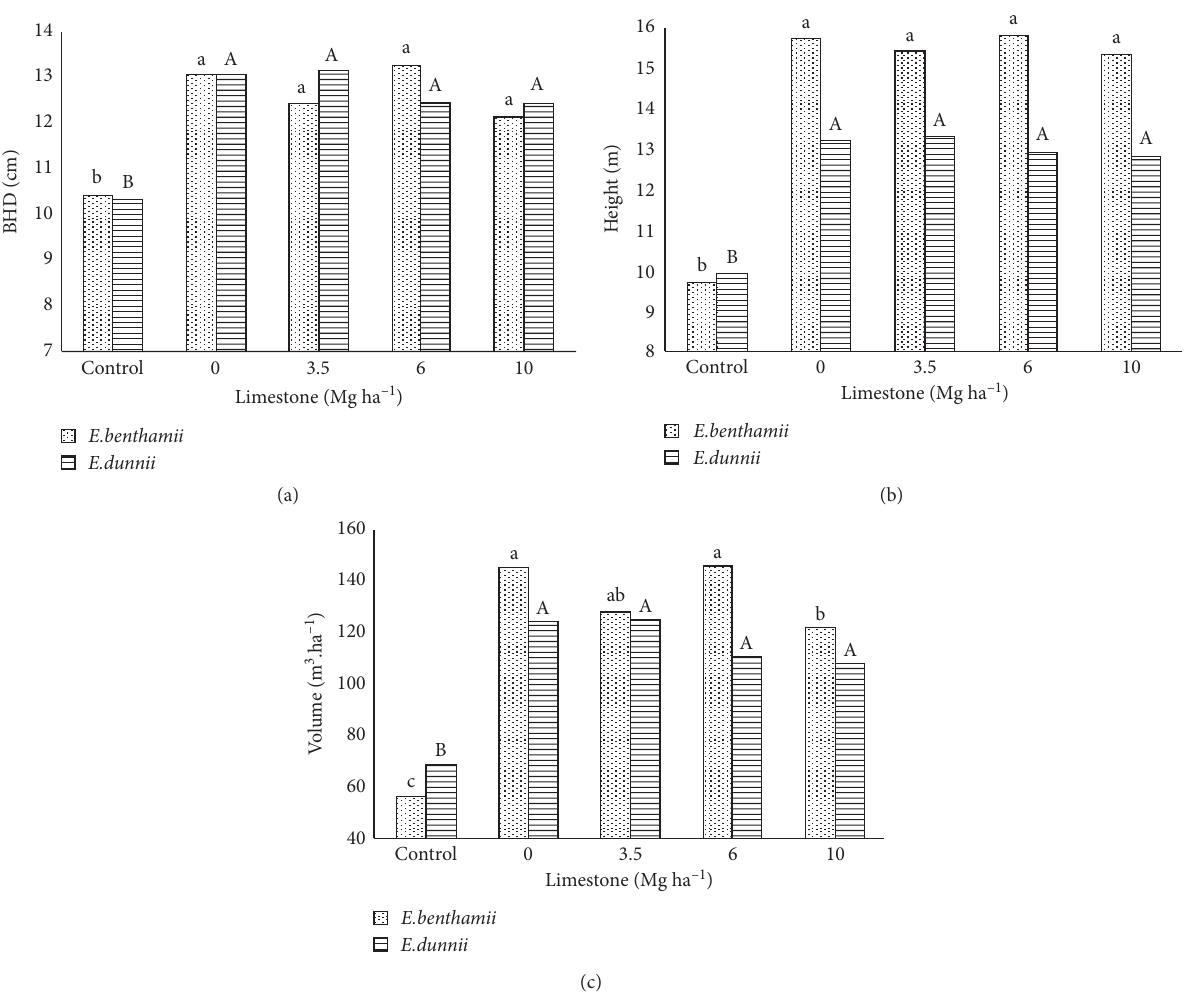
Figure 3: (a) Breast height diameter (BHD, cm), (b) height (m), and (c) volume (m3 ha − 1 ) in Eucalyptus benthamii and Eucalyptus dunnii in relation to liming. Averages followed by the same letter, lower and uppercase, do not differ between them by the Tukey test at 5% probability. Lowercase letters compare fertilization in relation to E. benthamii . Uppercase letters compare fertilization in relation to E. dunnii